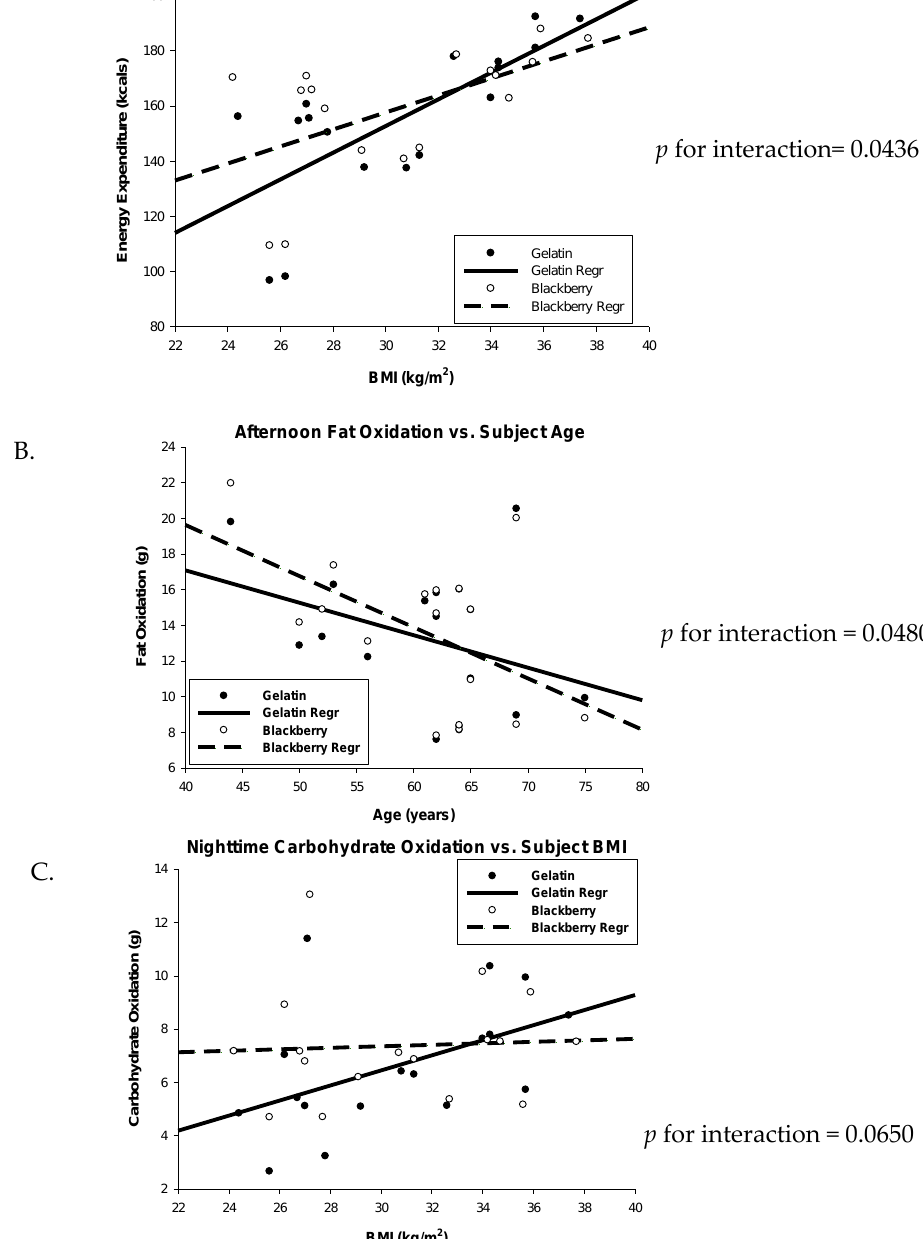
Figure 2. Interactions between treatment and BMI ( A) and ( C ) and treatment and age ( B ) for fuel utilization for adult men consuming blackberries vs. gelatin for 7 days. n = 17 subjects.